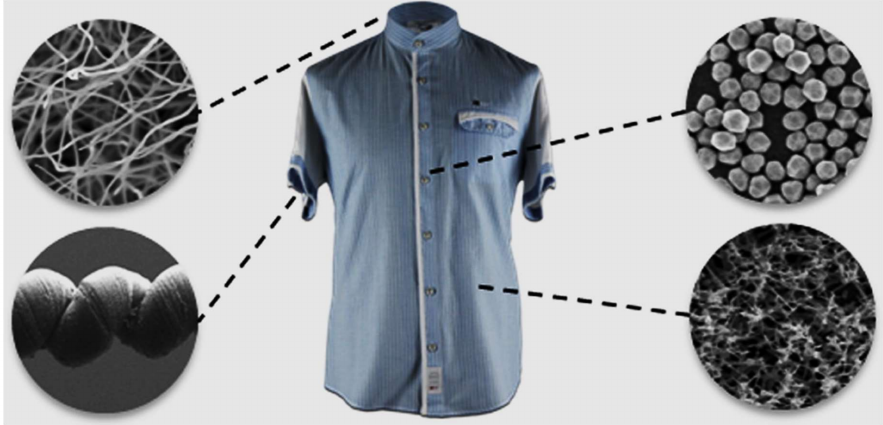
Figure 3. Nanotechnology in e-textiles: An overview. Reprinted with permission from [57]. Copyright (2016) American Chemical